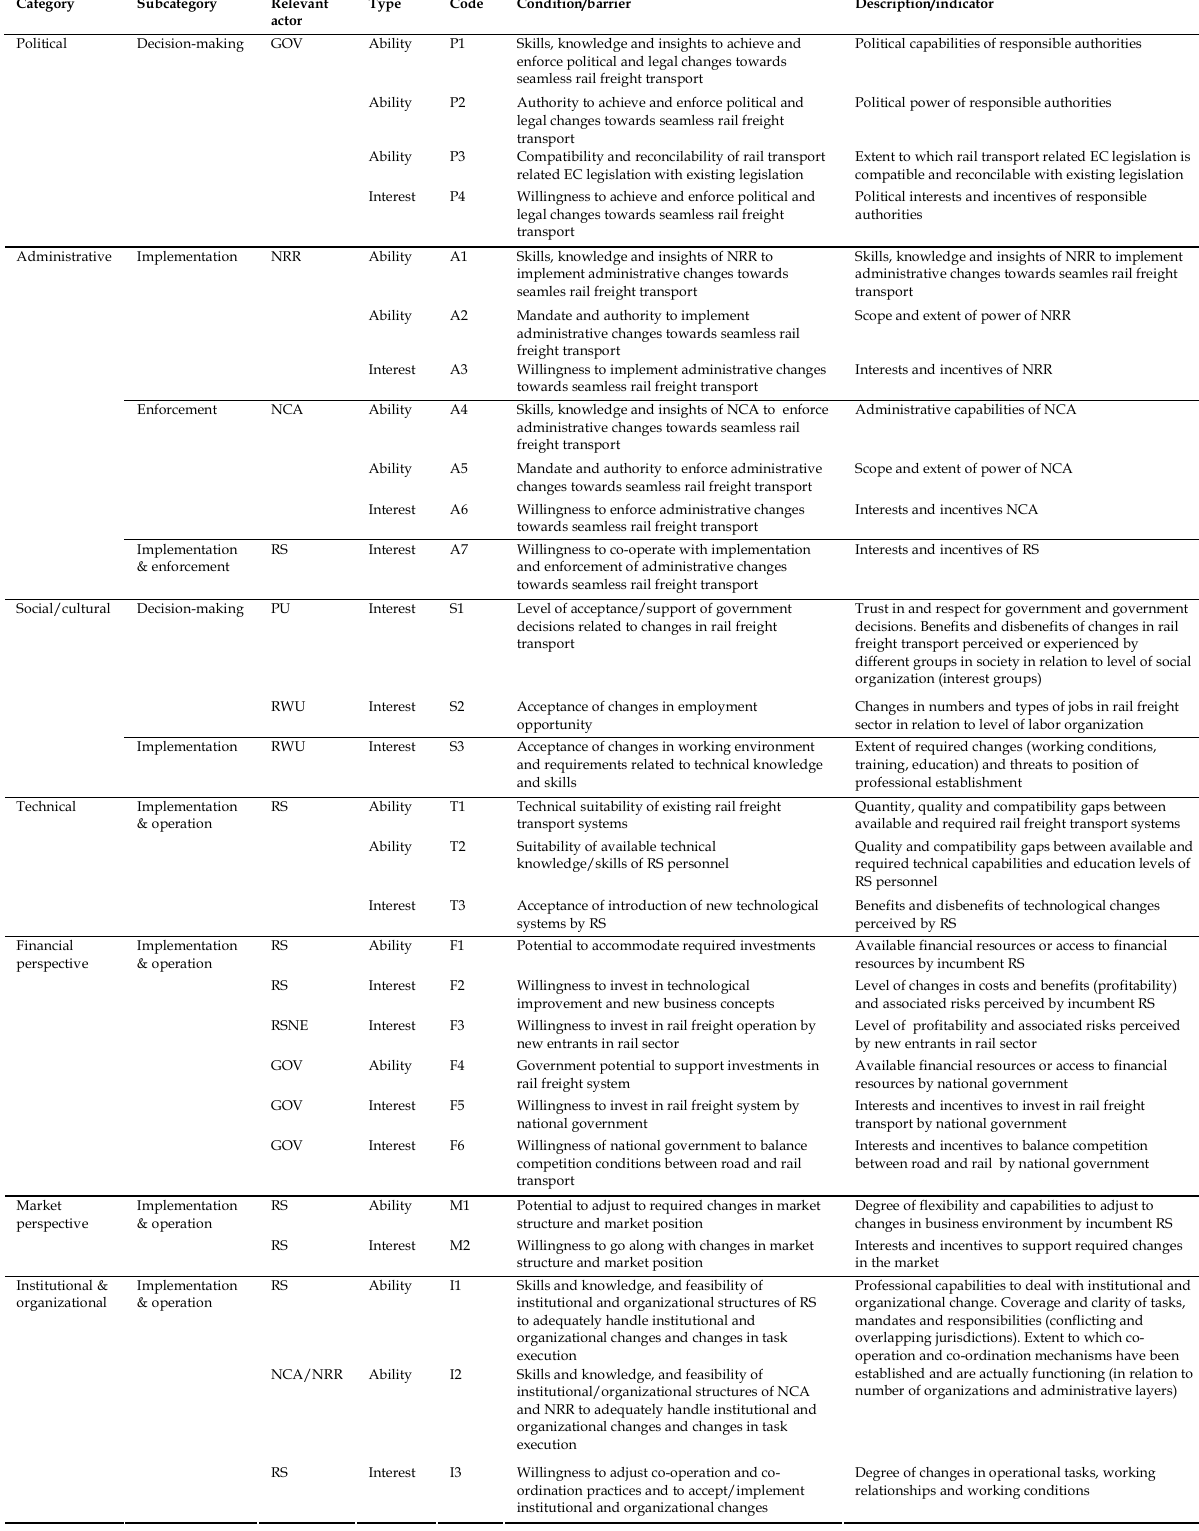
Table 3. Overview of implementation